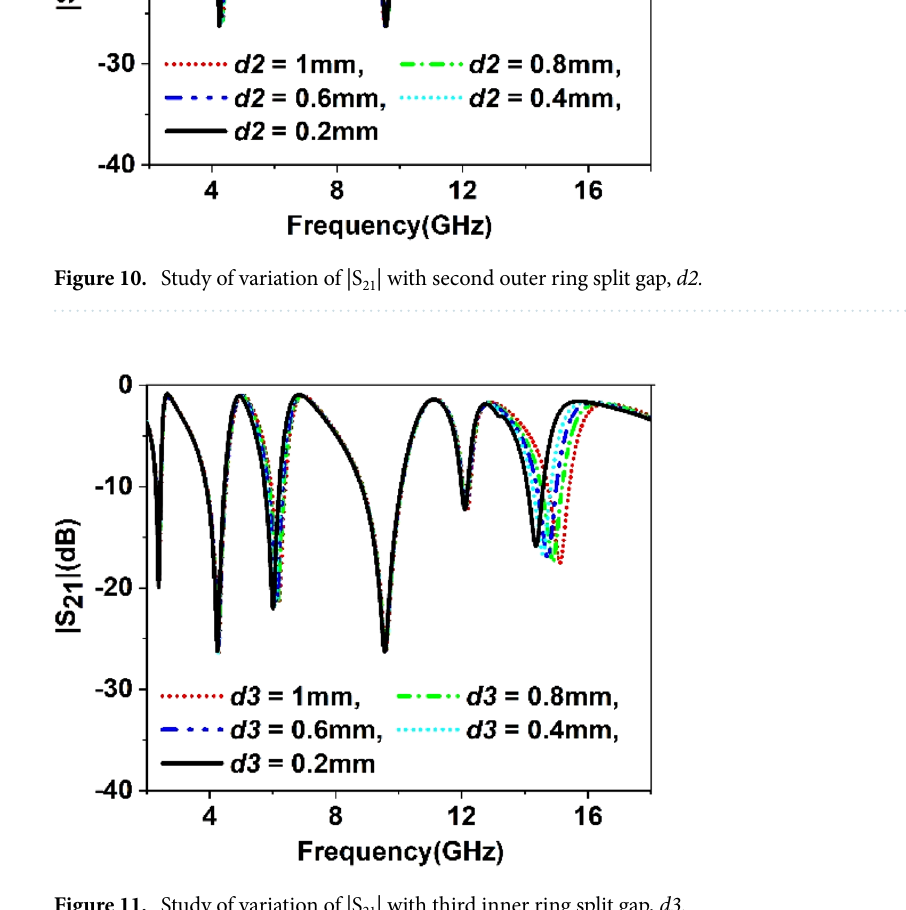
Figure 11. Study of variation of |S 21 | with third inner ring split gap,